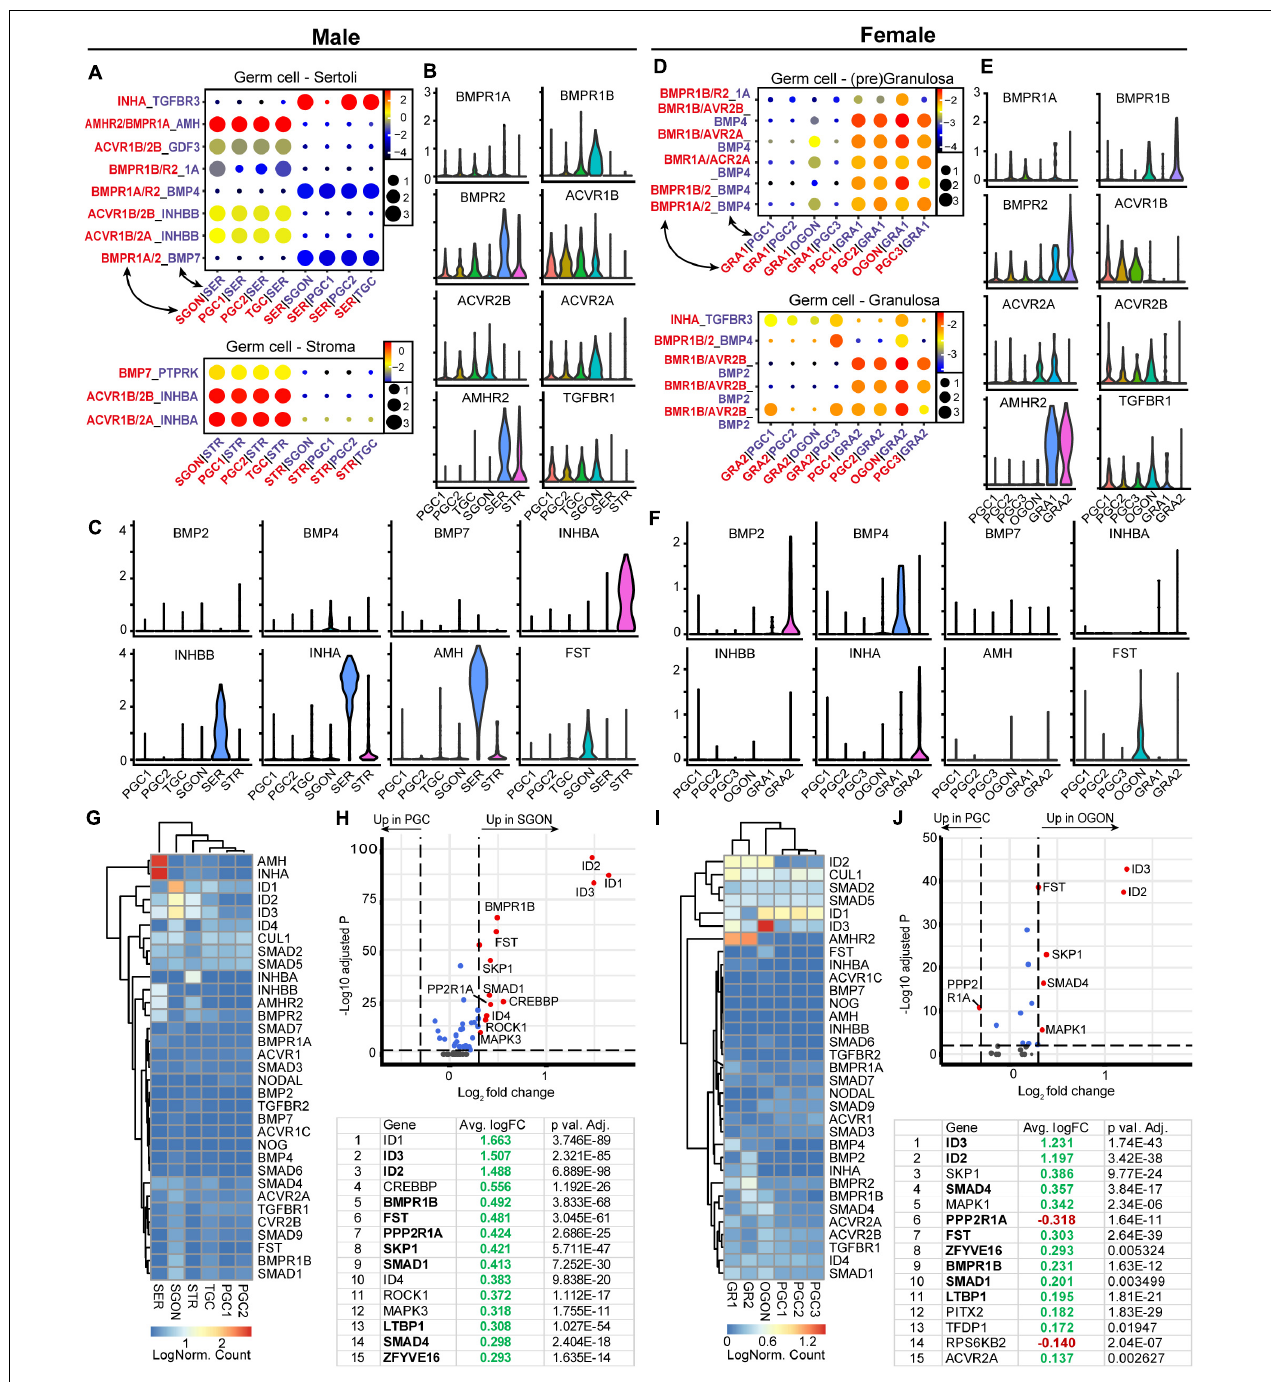
FIGURE 7 | Expression of TGF β /BMP ligand–receptor pairs and downstream pathway effectors in fetal gonads. (A) CellphoneDB analysis of TGF β /BMP interactions between different clusters in male fetal gonads. Depicted are − log 10 p -values (circle size) and log 2 means (circle color) for the interacting pairs, for selected pairwise cluster combinations. (B,C) Violin plots of selected TGF β /BMP-associated ligands and receptors in male germ and somatic clusters. (D) CellphoneDB analysis of TGF β /BMP interactions between different clusters in female fetal gonads. (E,F) Violin plots of selected TGF β /BMP-associated ligands and receptors in female germ and somatic clusters. (G) Heatmap of expression showing genes of interest associated with TGF β /BMP signaling pathway in male germ and somatic cell clusters. (H) A volcano plot showing TGF β /BMP-related genes between PGC and GON cluster in male gonads. Table shows the top 15 differentially expressed genes. Genes in bold are common between male and female, while genes in italics show divergent regulation. (I) Heatmap showing the expression of genes of interest associated with TGF β /BMP signaling pathway in female germ and somatic cell clusters. (J) A volcano plot showing TGF β /BMP-related genes between PGC and GON clusters in female gonads. Table shows the top 15 differentially expressed